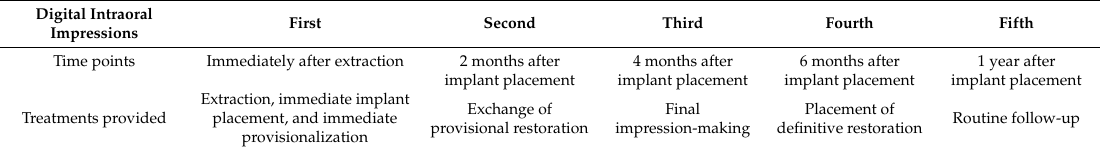
Table 1. Time points at which digital intraoral impressions were